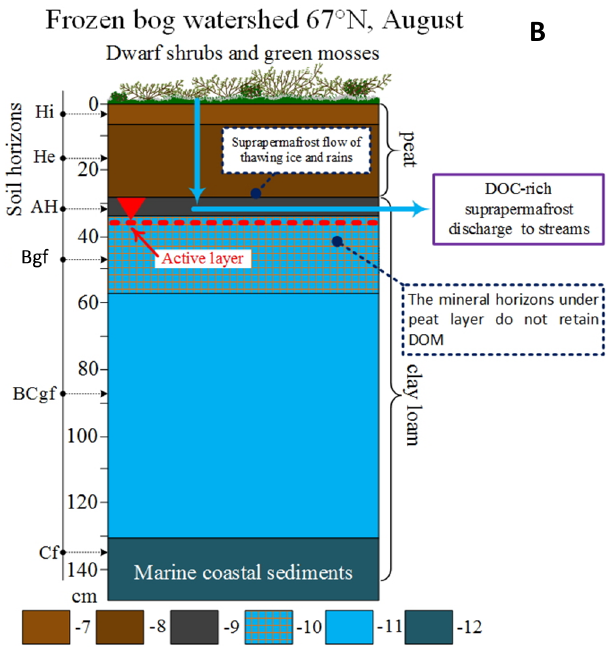
Figure 6. Scheme of DOC pathways within the soil profile and to the river. (a) In forest watershed of the south, permafrost-free zone (57 ◦ N). Soil horizons (FAO, 2006): (1) O (Mor, forest lit- ter), (2) medium-decomposed peat (He) transforming into strongly decomposed peat (Ha) in the bottom layer, (3) mollic humic hori- zon, (4) ABg surface horizons with stagnic properties, (5) Bg mid- dle stagnic horizon, and (6) Cgk carbonate-bearing clays and clay loam. (b) DOC pathways in frozen bog peatlands of continuous permafrost (67 ◦ N). Soil horizons (FAO, 2006): (7) weakly decom- posed peat (Hi), (8) partially decomposed peat (He), (9) humic hori- zons (AH), (10) cryoturbated frozen stagnic horizon (Bgf), (11) frozen stagnic horizon (BCgf), and (12) sedimentary deposits (Cf). In the south, DOC is retained by clay, and deep in the soil profile by clay loam with carbonates. In the north, the active layer depth does not exceed the overall thickness of the peat and thus the leachates of ground vegetation and peat layer do not meet mineral horizons during their transit to the